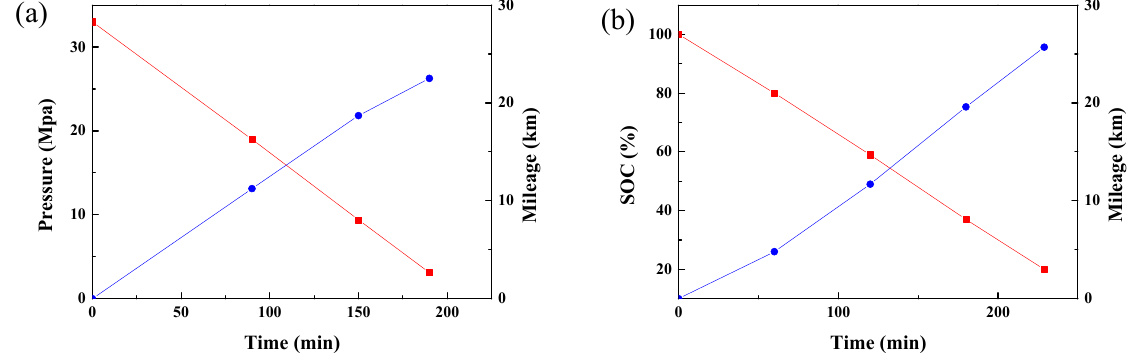
Figure 7. The mileage of the PEMFC forklift ( a ) and lithium ion battery forklift ( b ).